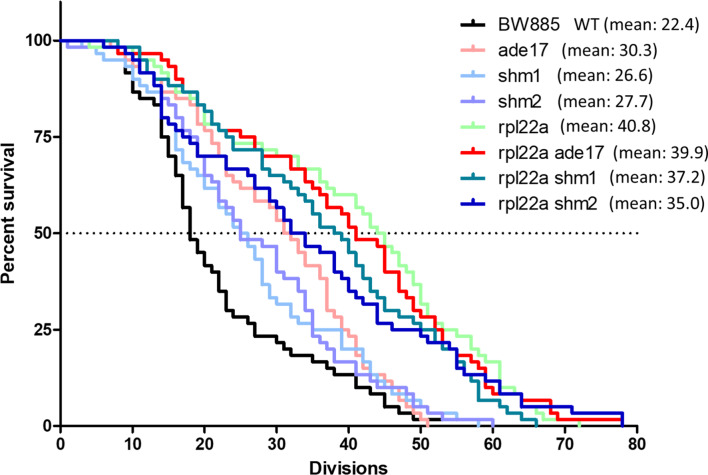
Deletion of enzymes of one-carbon metabolic enzymes does not further extend the replicative longevity of rpl22aΔ cells.Survival curves for wild type MATα (BW885) cells (shown in black), compared to experiment-matched cells of the indicated genotype. Mean lifespans are shown in parentheses. The lifespans were determined from 60 cells in each case.